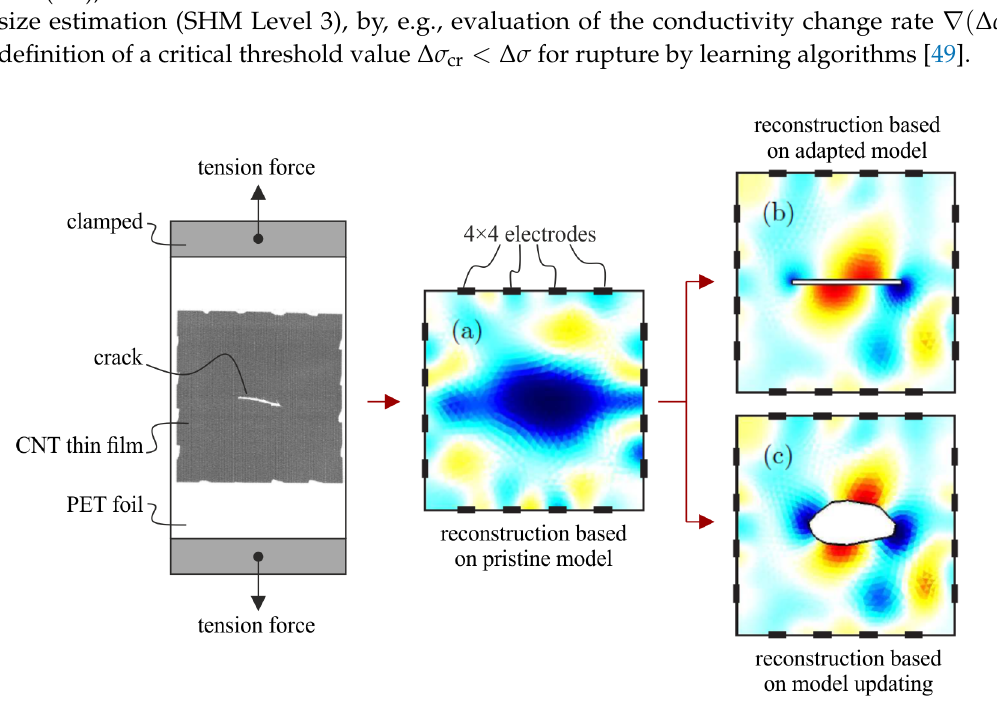
Figure 3. CNT embedded thin film attached to a PET tension test specimen with crack (cut by knife) loaded in vertical direction (left) and conductivity reconstruction results ( a–c )